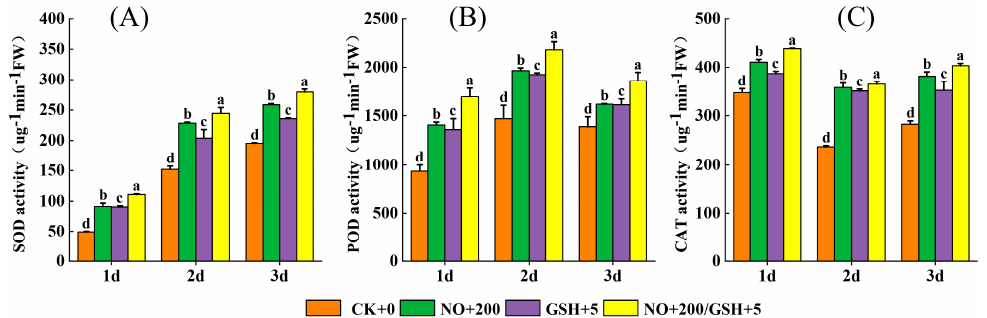
Figure 5. Effects of NO and GSH on the activities of (( A ): SOD), (( B ): POD), and (( C ): CAT) of cowpea seedlings under low-temperature stress. Different letters indicate statistically significant differences according to Duncan's multiple range test at p < 0.05.